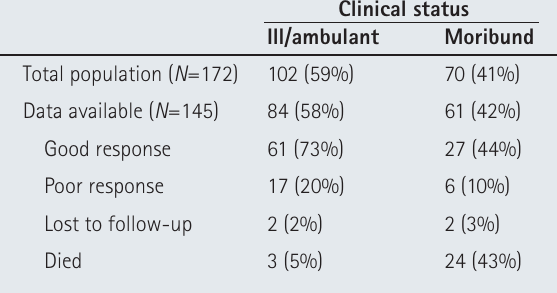
TABLE I. BREAKDOwN Of AvAILABLE PATIENT OUTCOMES By BASELINE CLINICAL STATUS AT TREATMENT INITIATION